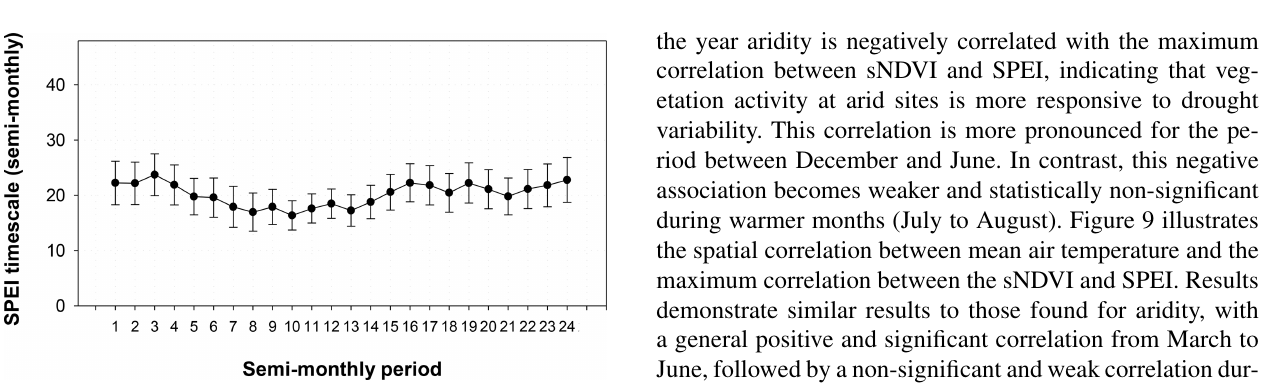
Figure 5. Average and standard error of the SPEI timescale at which the maximum Pearson’s r correlation coefficient between the sNDVI and SPEI is